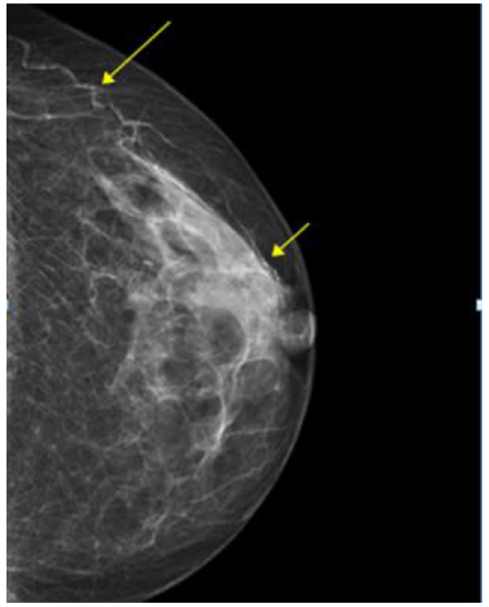
Figure 1. A digital mammogram. The yellow arrows are showing examples of Breast Arterial Calcifications (BACs).